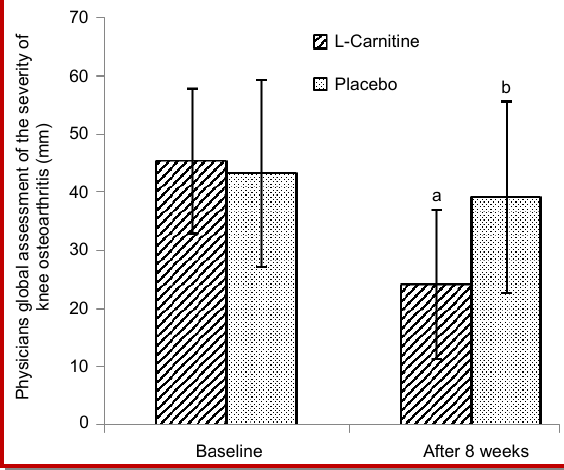
Figure 2. Physician’s global assessment of the severity of knee osteoarthritis (100 mm VAS) in the treatment groups at baseline and after 8 weeks. Values are means ± SD (n = 33 in the L- carnitine group and n = 36 in the placebo group). The mean values were significantly different compared with baseline in both groups (paired t-test): a p>0.05, b p<0.05. The data were tested using independent-sample t test at baseline and AN- COVA test, adjusted for baseline values and duration of